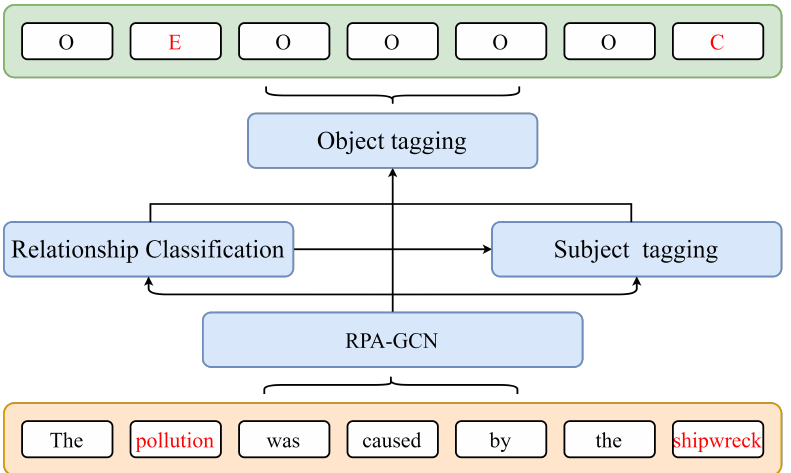
Figure 3. Research